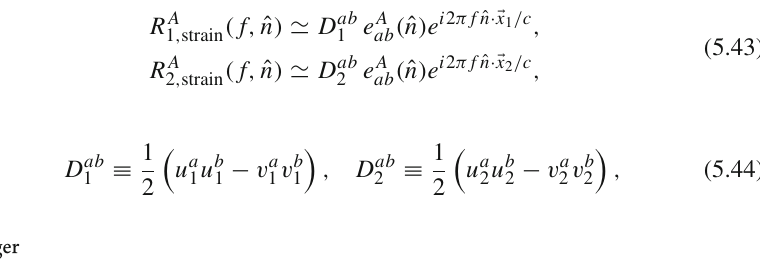
Fig. 33 An extension of Fig. 32 to lower and higher frequencies, and plotted on a log–log scale. The position of the labels show the relative location of the frequency bands for gravitational-wave searches using ground-based interferometers like LIGO, space-based interferometers like LISA, spacecraft Doppler tracking, and pulsar timing arrays, expressed in units of c /( 2 L ) . See also Table 5 for more